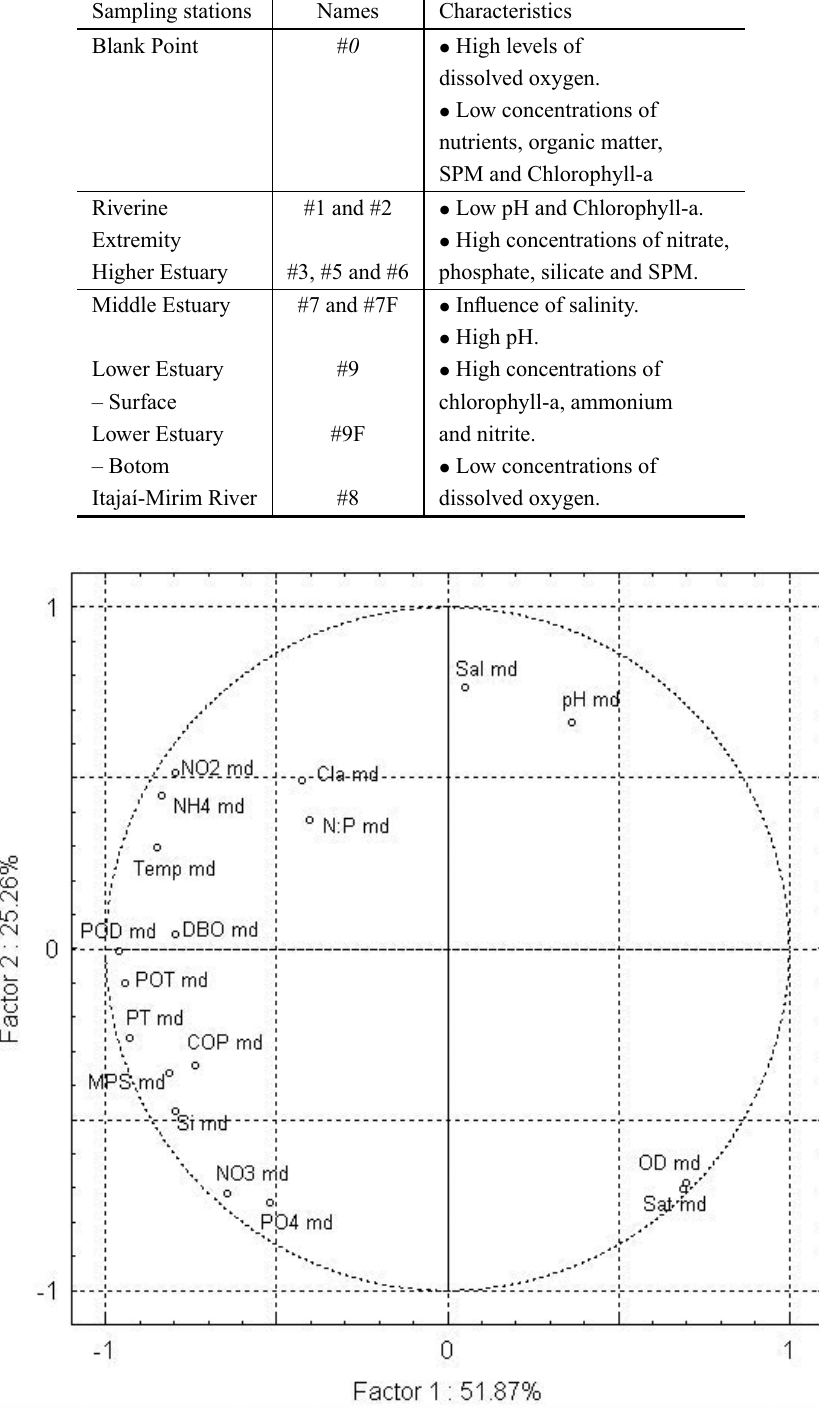
An Acad Bras Cienc (2010) 82